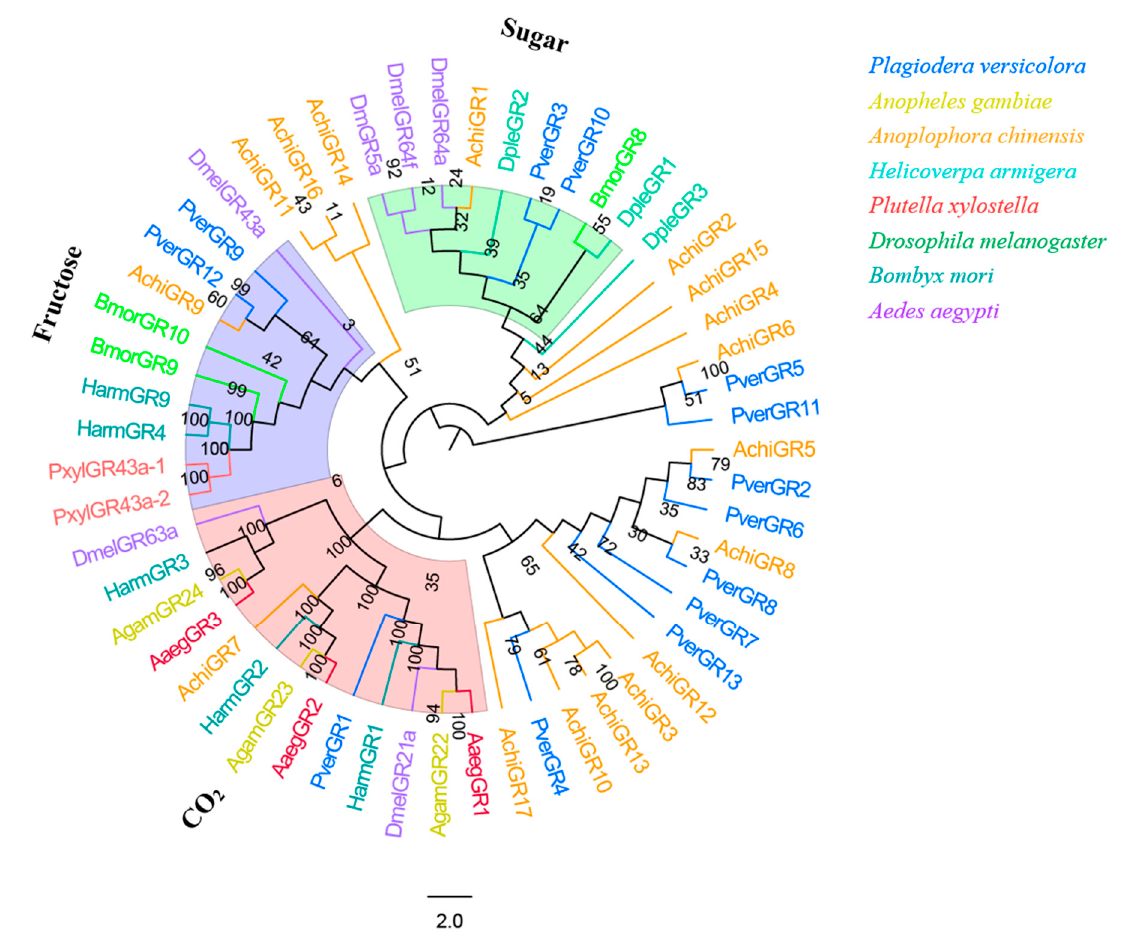
Figure 8. Phylogenetic tree of insect GR. The P. versicolora genes are shown in blue. The tree was constructed using MEGA6 with the Neighbor-joining method. The sugar subfamily does not include the fructose receptors.